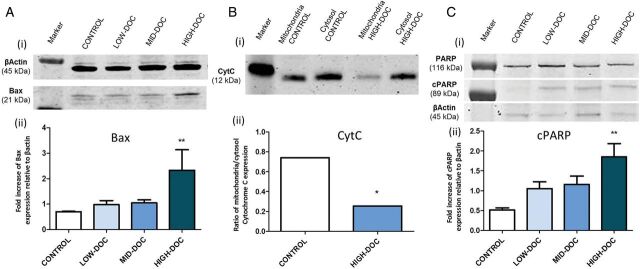
Docetaxel exposure increases Bax expression, releases Cytochrome C into the cytosol and cleaves poly(ADP-ribose) polymerase (PARP) in mice. Ai, Bi and Ci: Representative images of western blotting of whole ovary proteins, for (A) Bax, (B) Cytochrome C and (C) cleaved PARP (cPARP). Aii, Bii and Cii: Densitometric analyses of proteins, expressed as relative to that of β-actin (Aii, Cii) or as a ratio of mitochondrial: cytosol expression (Bii). Bax and cPARP expression increased significantly only when ovaries were exposed to HIGH-DOC. HIGH-DOC treatment also induced release of Cytochrome C from the mitochondria into the cytosol. For Bax, a total of six ovaries were used for each treatment group in three independent experiments and Kruskal–Wallis followed by Dunn post hoc tests were applied. For CytC, a total of 10 ovaries were used for each treatment group in five independent experiments and a paired t-test was used. For cPARP, a total of 10 ovaries were used for each treatment group in five independent experiments and Kruskal–Wallis followed by Dunn post hoc tests were applied. Data are mean ± SEM. P < 0.01 (**) for DOC versus CONTROL.